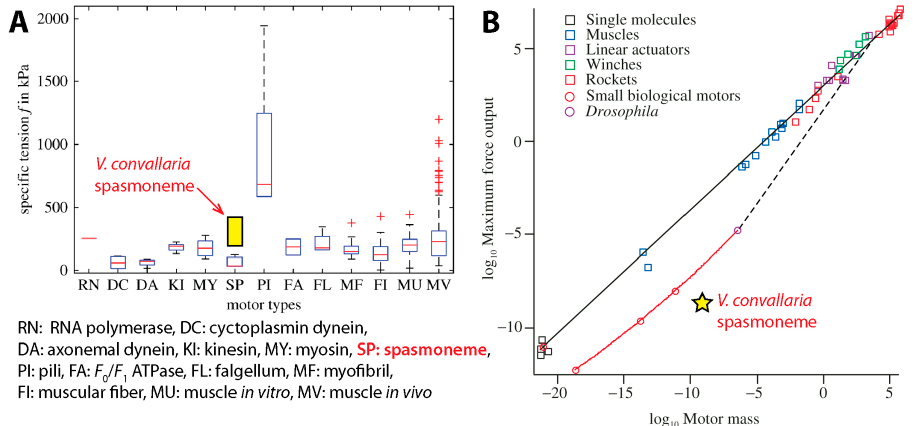
Figure 12. Comparison of the Vorticella spasmoneme with other motors. ( A ) Tensile stress (reproduced from [133]). Because the peak tension of live V. convallaria [14] and the isometric tension of extracted V. convallaria [23] are considered in [133], the isometric tensions of live V. convallaria [16] are included for rigorous comparison; ( B ) maximum force output (N) with respect to their mass (kg) (reproduced from [134,135]).